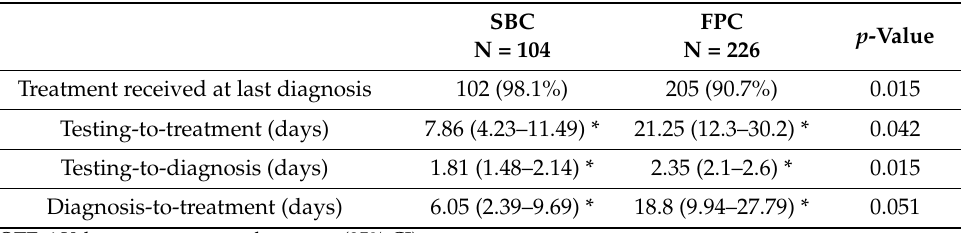
Table 3. Chlamydia and gonorrhea treatment outcomes for subgroup of patients that were not treated